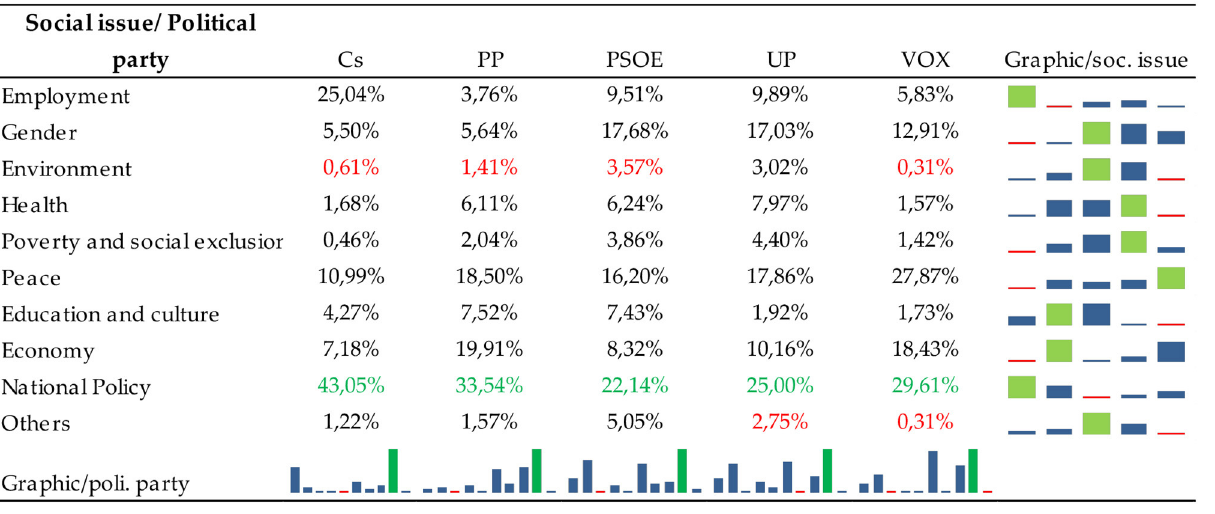
TABLE 7 | Social issues posted by political parties on Facebook during the 2015–2019 General Elections.